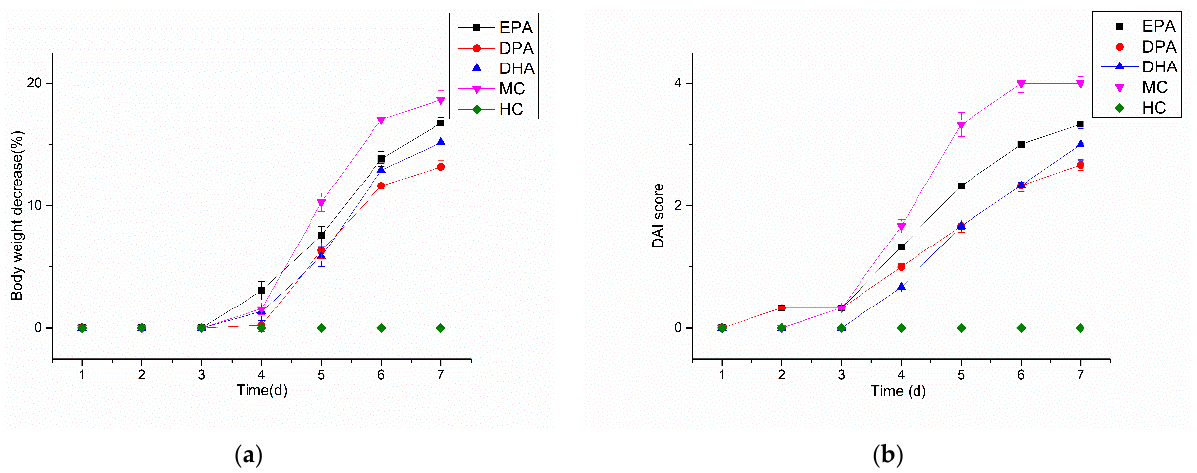
Figure 1. Changes in bodyweight ( a ) and DAI ( b ) score during DSS treatment. Note: EPA, DPA, DHA, MC, HC represent EPA group, DPA group, DHA group, model control group, health control group, respectively.